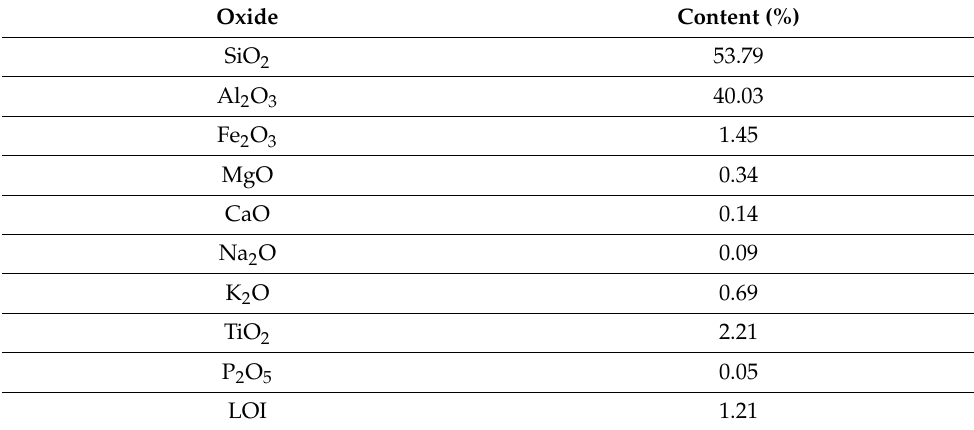
Table 1. Chemical composition of